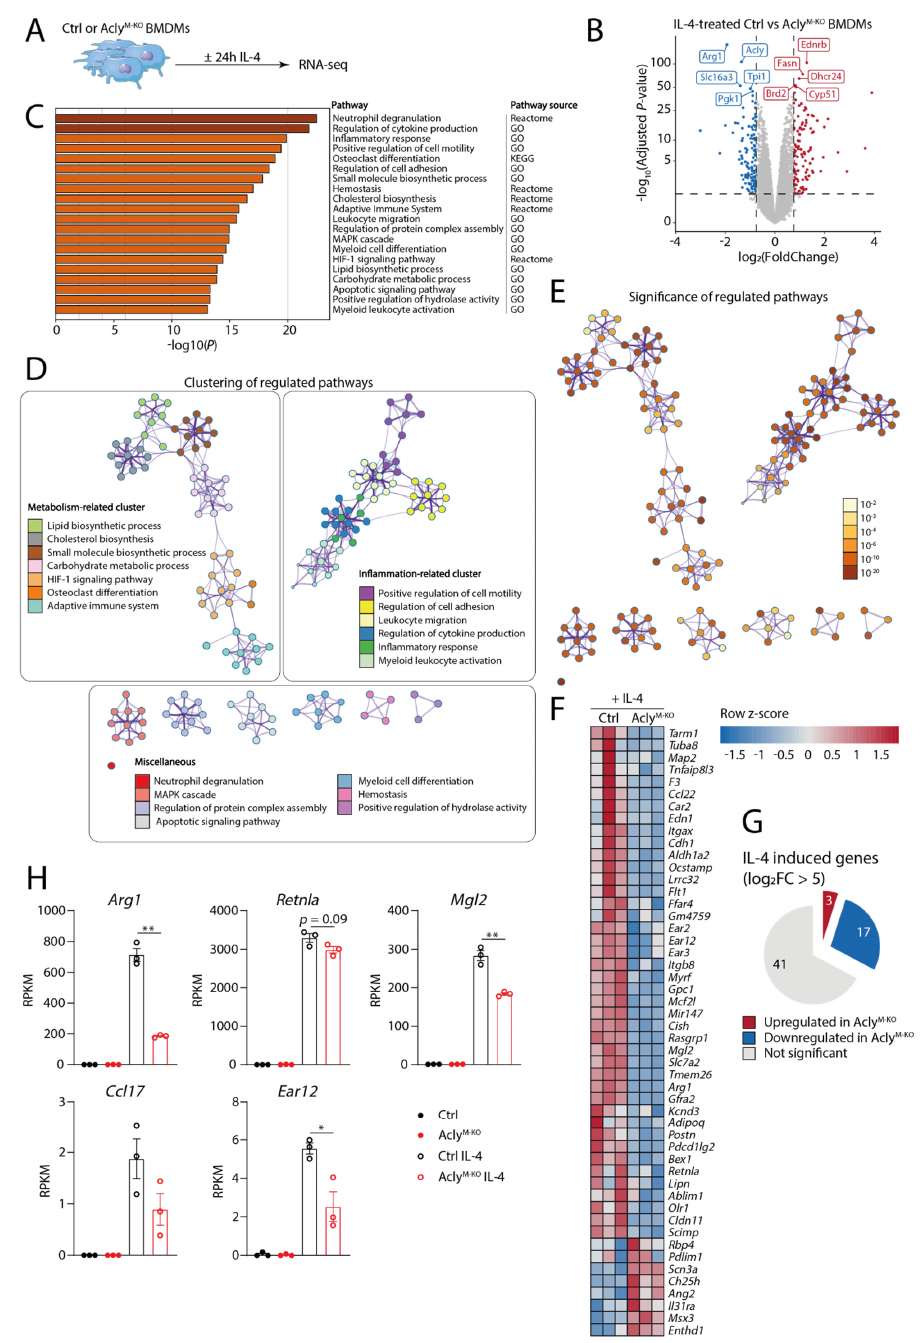
Figure 1. Acly regulates IL-4-induced macrophage activation in vitro . ( A ) Acly fl/fl Ctrl and Acly M-KO BMDMs were left untreated or were treated with IL-4 for 24 h for RNA sequencing. ( B ) Volcano plot of IL-4-treated Acly fl/fl Ctrl and Acly M-KO BMDMs. ( C ) Top 20 differentially regulated pathways of IL-4-treated Acly fl/fl Ctrl and Acly M-KO BMDMs. ( D ) Networks with clustered pathways as identified in ( C ), colored by cluster and ( E ) by p -value. ( F ) Heatmap showing the effect of Acly M-KO on top 50 highly IL-4-induced genes. ( G ) Pie chart quantifying up-, down-, and not significantly regulated genes ( p adjusted < 0.05, log 2 FC > |0.58|) by Acly M-KO on highly IL-4-induced genes. ( H ) Expression of genes previously identified as impacted by Acly inhibition for control and Acly M-KO BMDMs, naive or treated with IL-4. p -values are indicated as <0.05 *, <0.01 **. Results are shown as mean ± SEM from n = 3 technical replicates from three pooled